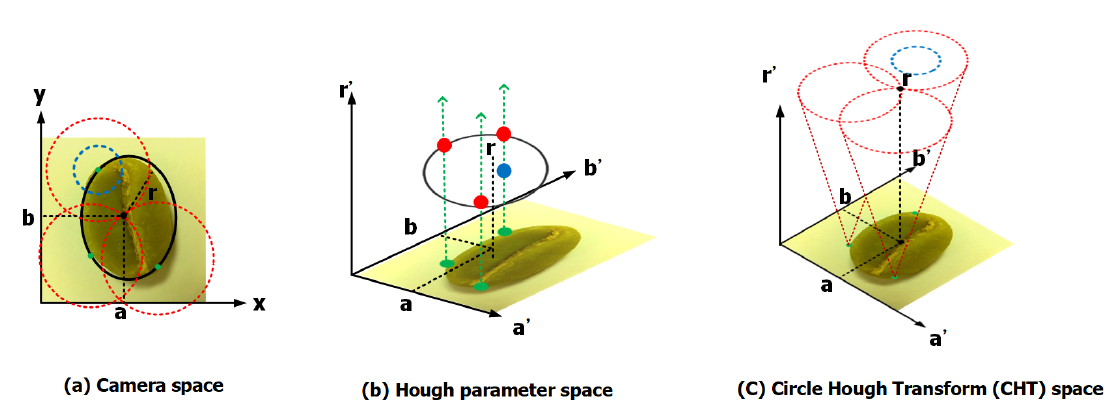
Figure 6. Illustration of the HC transform in the scenario of detecting a coffee